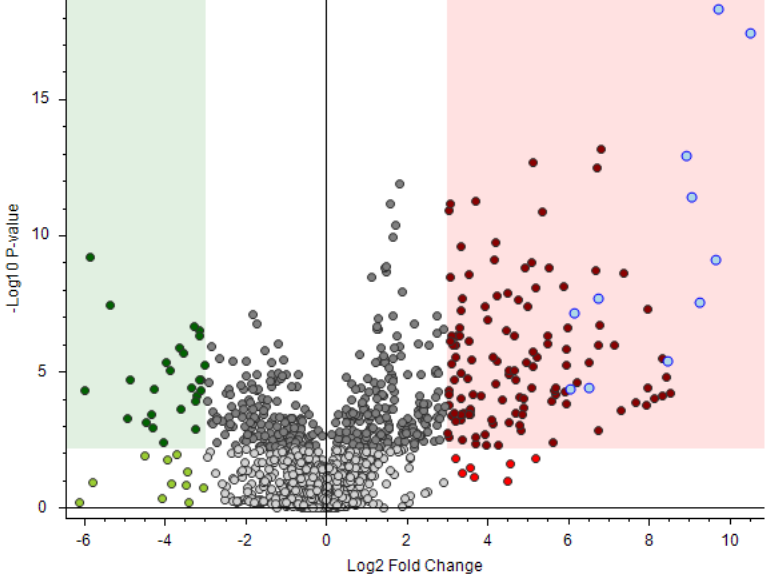
Figure 3. Differential analysis in order to reveal the spiked compounds (labeled in blue), attempting to separate them from background compounds (labeled in red) in the experiment described in Section 3.2. Eight individual samples from another DWTP were used as reference samples. For each feature, i.e., combination of m / z and RT (isotopes and common adducts removed), detected in the data set, the fold change (i.e., the ratio between the median peak area of the spiked sample and the median peak area of the reference samples) was calculated ( x -axis: Log2 fold change). Data from all injections (triple injections for the spiked sample and single injections of the eight references) were used in order to calculate the level of significance of the fold change ( y -axis: − Log10 p -value). The red shaded area is for comparisons between Figures 3–5 (see text).